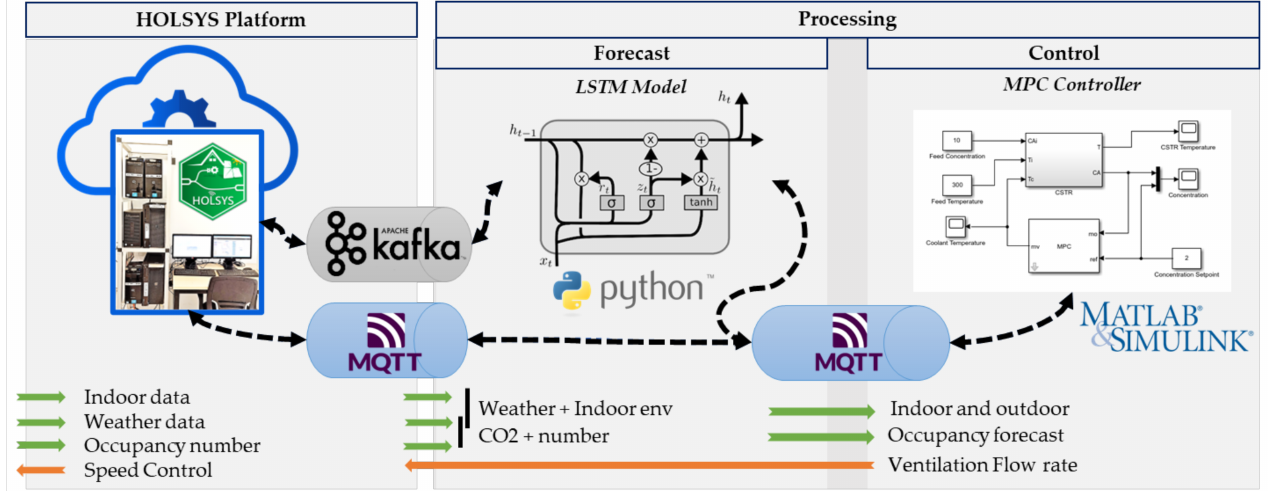
Figure 6. General architecture platform for controlling ventilation system based on occupancy forecast and CO 2